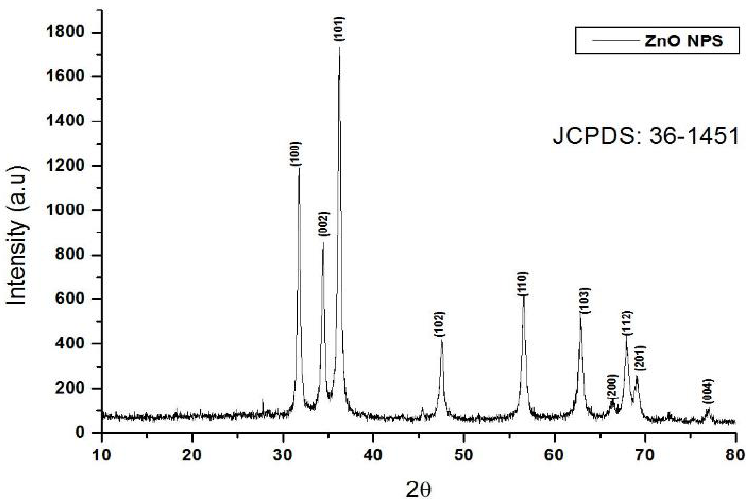
Figure 3. X-ray diffraction (XRD) analysis of the ZnO NPs.